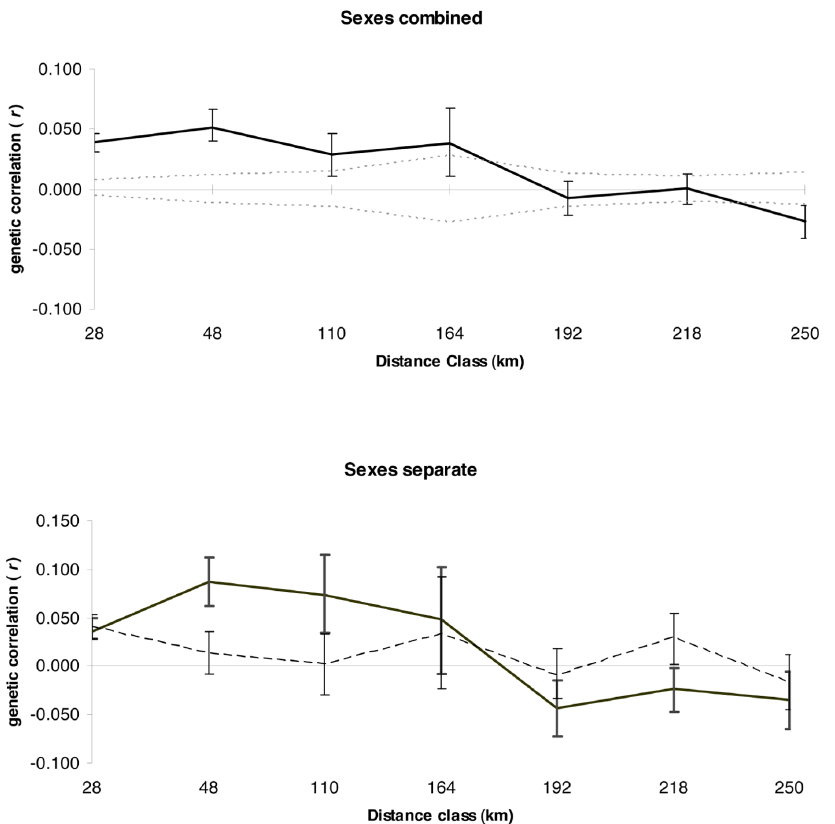
Figure 1. Global spatial autocorrelation at variable distance classes. Correlogram plots based on global spatial autocorrelation analyses conducted with variable distance classes. The y-axis is the genetic correlation coefficient ( r ) and the x-axis is the distance class (km). (a) both sexes combined; confidence intervals (95%) were calculated using bootstrapping (error bars) and permutation tests (dashed lines), (b) female (solid line) and male (dashed line); confidence intervals (95%) were calculated using bootstrapping (error bars).